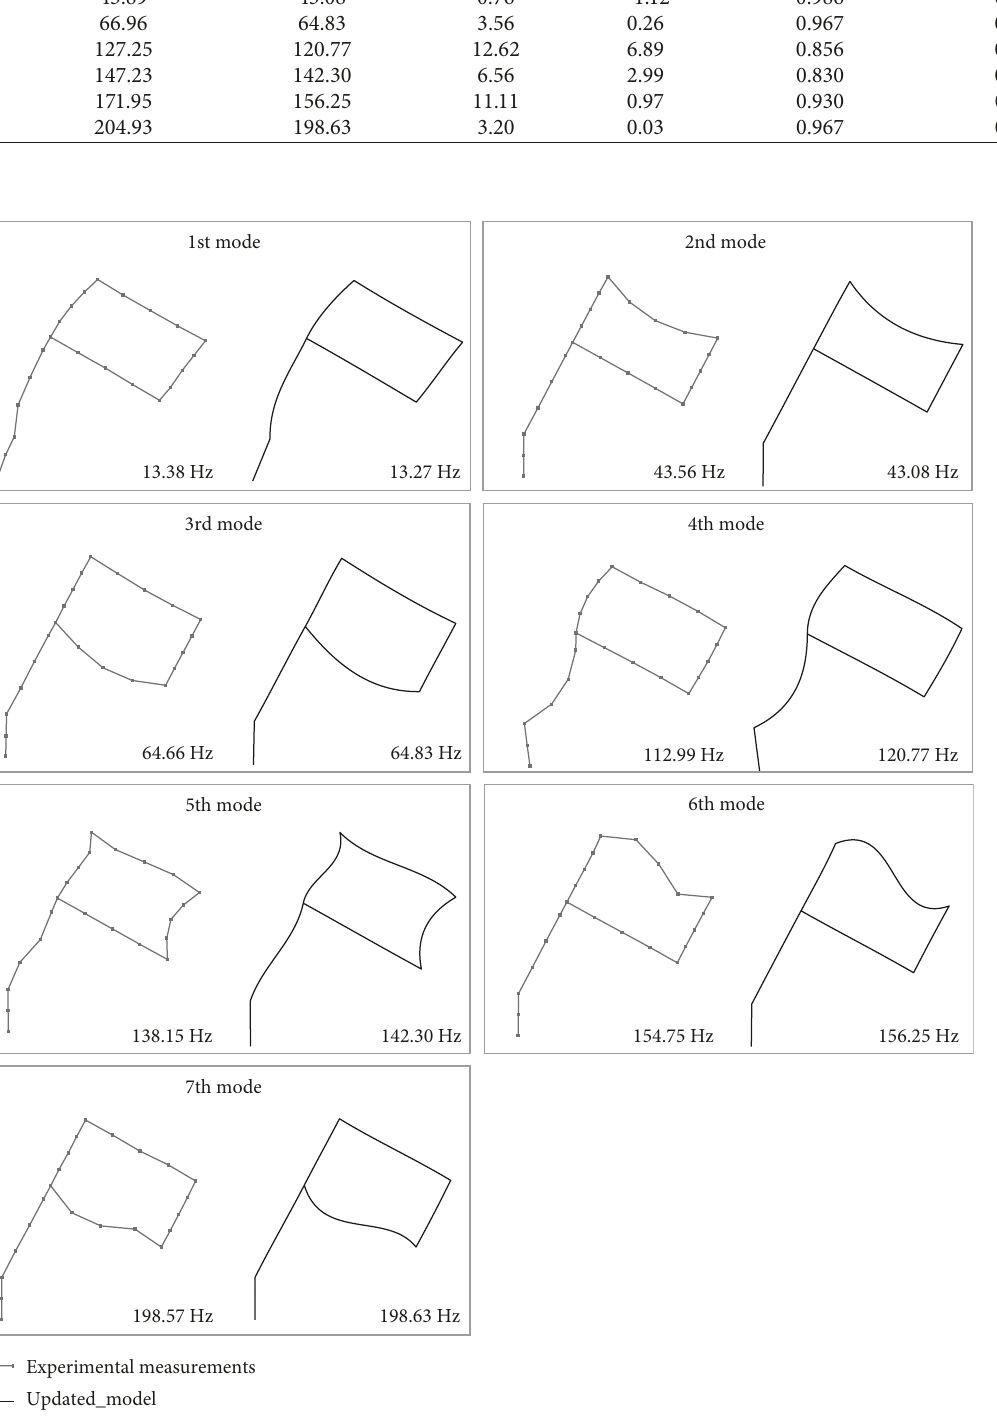
Figure 6: Shapes of the seven vibrational modes: experimental (left) and updated (right)